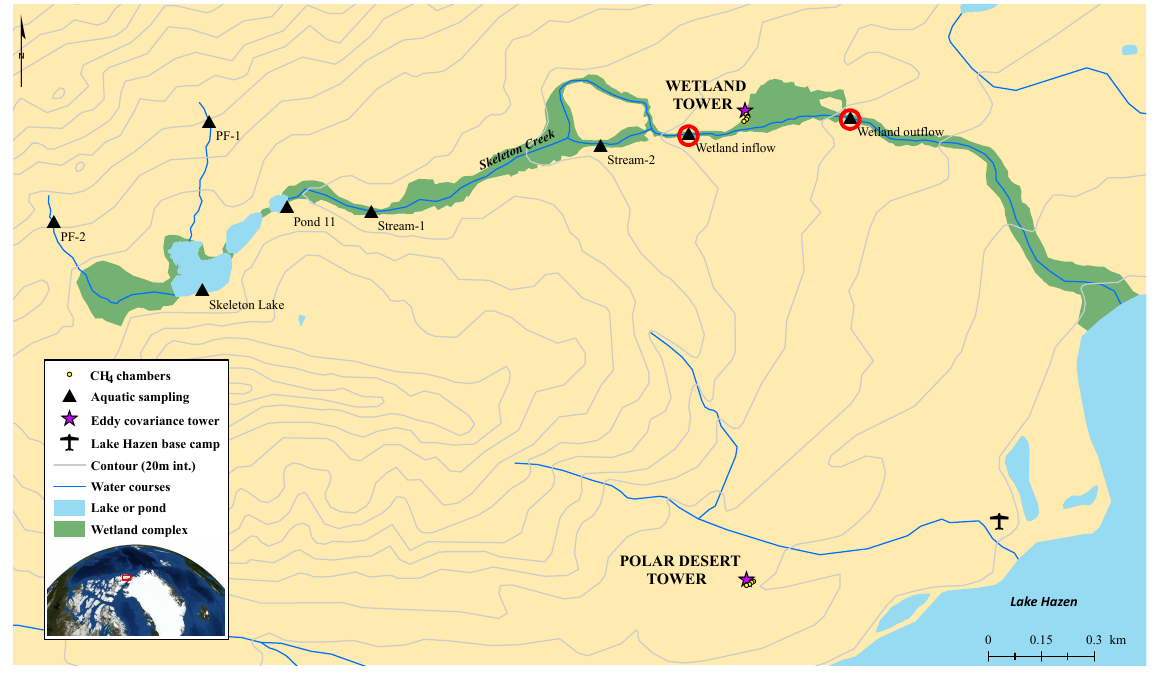
Figure 1. Lake Hazen base camp in Quttinirpaaq National Park, Nunavut, Canada (81.8 ◦ N, 71.4 ◦ W). Both the polar desert and meadow wetland study sites are shown with static chamber, eddy covariance and aquatic CH 4 sampling locations indicated. Emphasis added to aquatic sites upstream and downstream of the wetland. PF sites indicate permafrost seep streams and Stream sites indicate Skeleton Creek